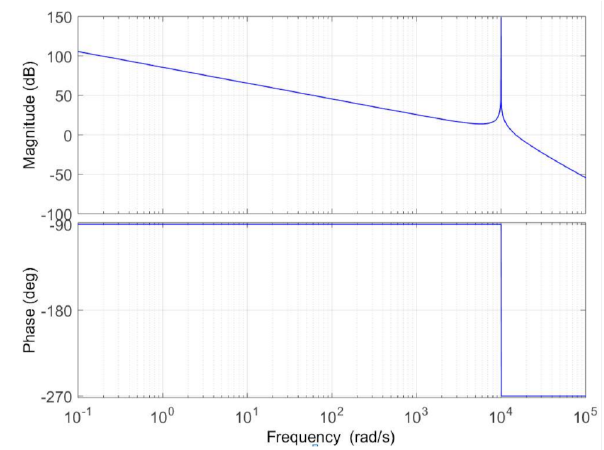
Figure 12. The bode waveform of current loop